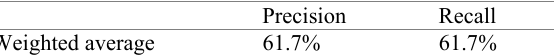
Table 3: Performance of weighted average approach on study area A with normalized and equally weighted measures